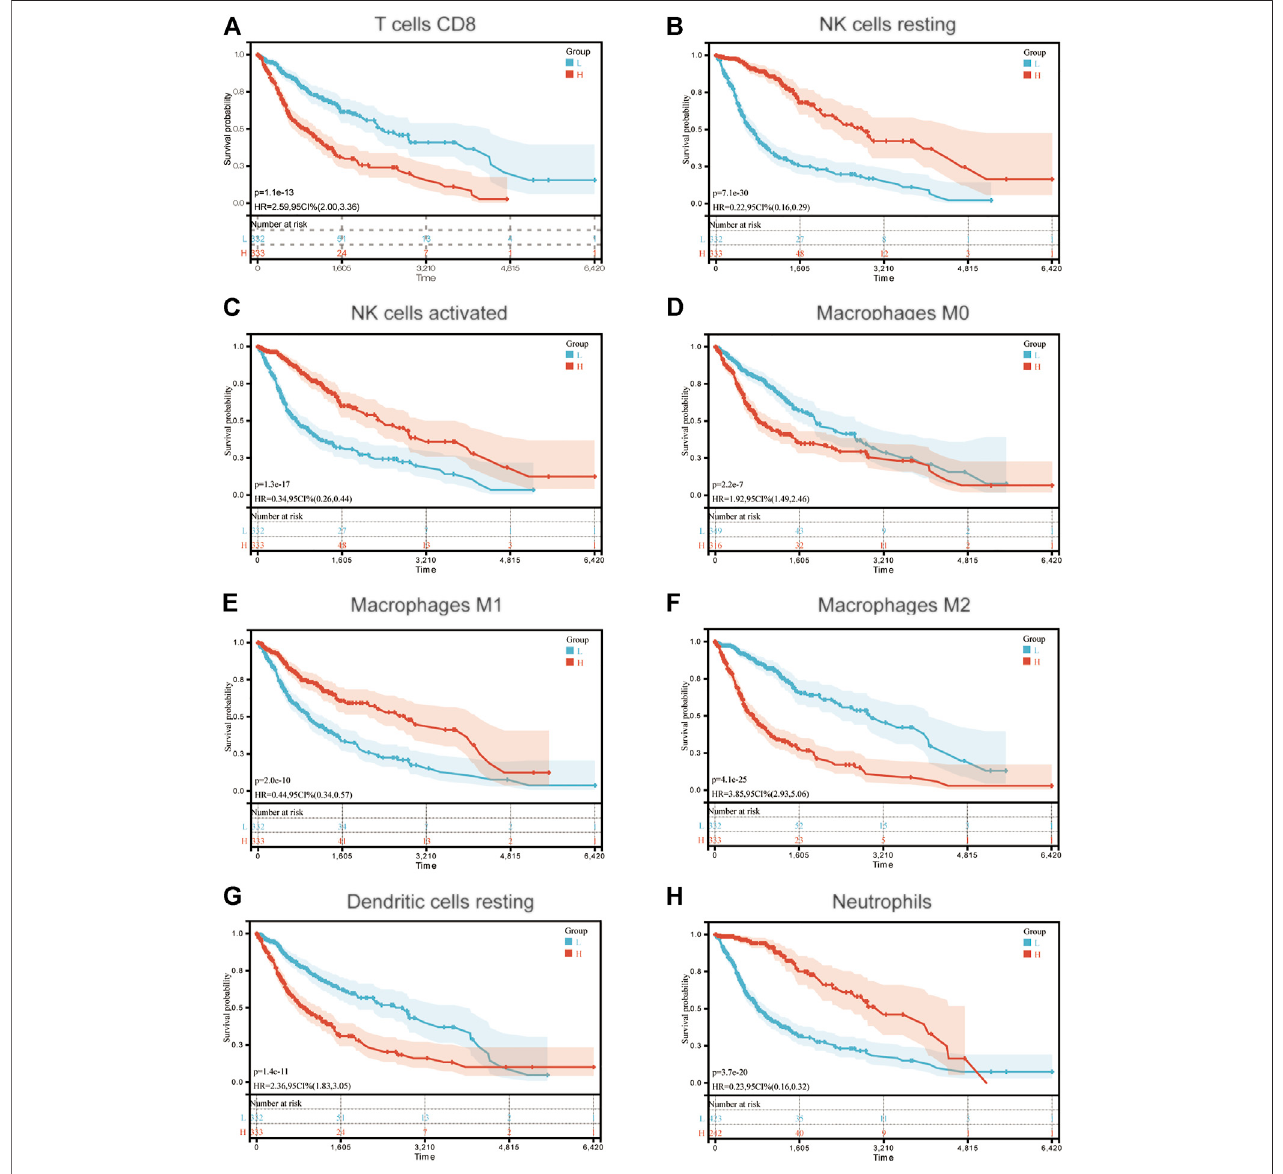
FIGURE 5 | Association between OS and (A) T cells CD8; (B) NK cells resting; (C) NK cells activated; (D) Macrophages M0; (E) Macrophages M1; (F) Macrophages M2; (G) Dendritic cells resting and (H) Neutrophils in patients with glioma. OS, overall